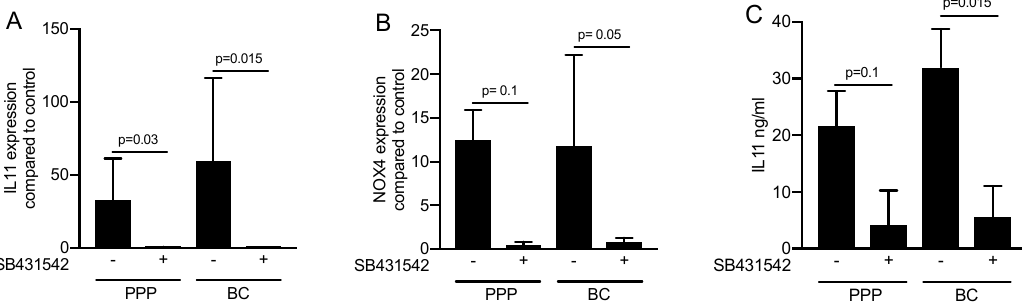
Figure 4. Inhibition of the TGF- β receptor type I kinase blocked the expression of respective target genes. Gingival fibroblasts were exposed to 30% of PPP and buffy coat (BC) with and without the TGF- β receptor 1 antagonist SB431542. Expression analysis of ( A ) IL11 and ( B ) NOX4 is expressed as x-fold increases compared to the basal levels of untreated cells. ( C ) The levels of IL11 in the supernatant of the fibroblasts was presented in ng/mL. Bar graphs show the means and standard deviation of four independent experiments (N = 4). Statistical analysis was based on a paired t -test.